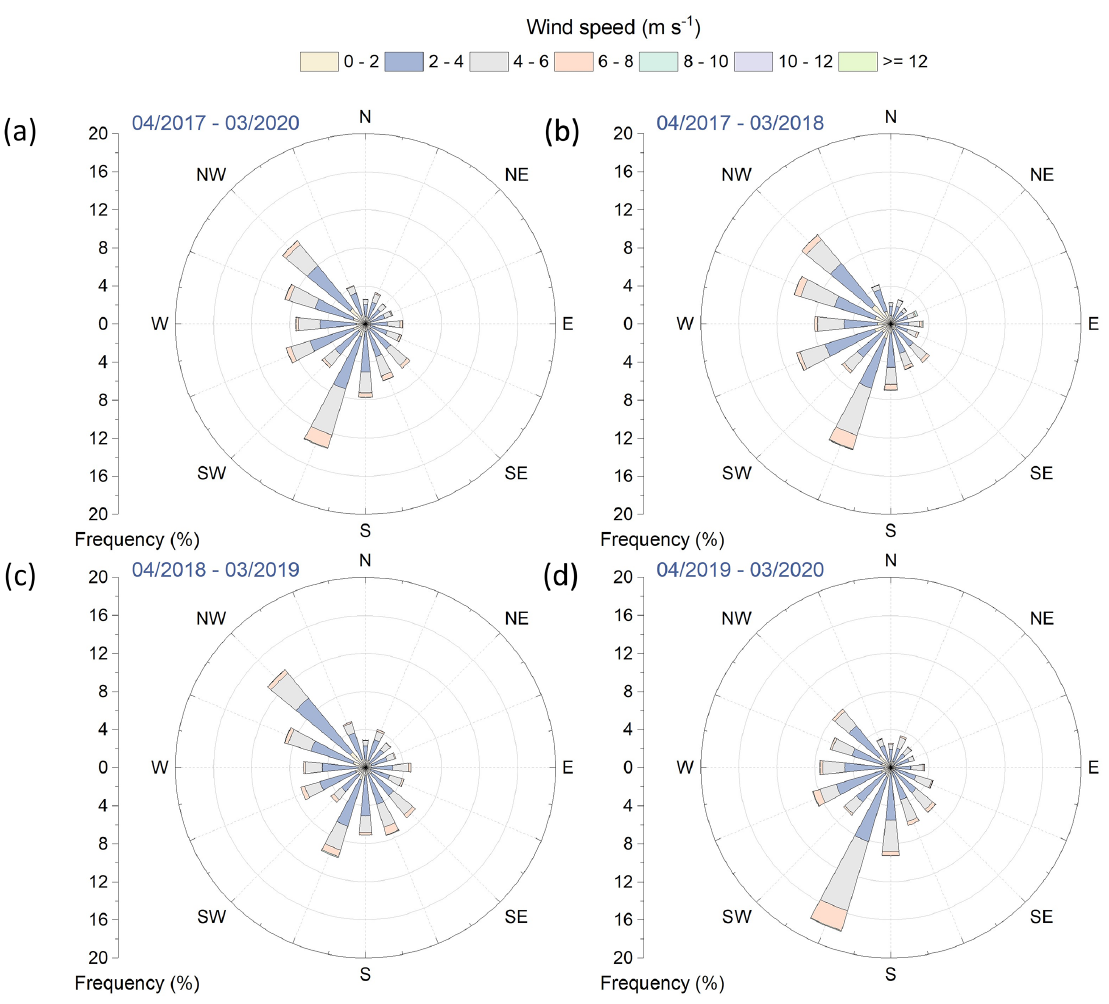
Figure A1. Wind roses for (a) the whole 3-year period, (b) the first year, (c) the second year, and (d) the third year. Please note that the date format used in this figure is